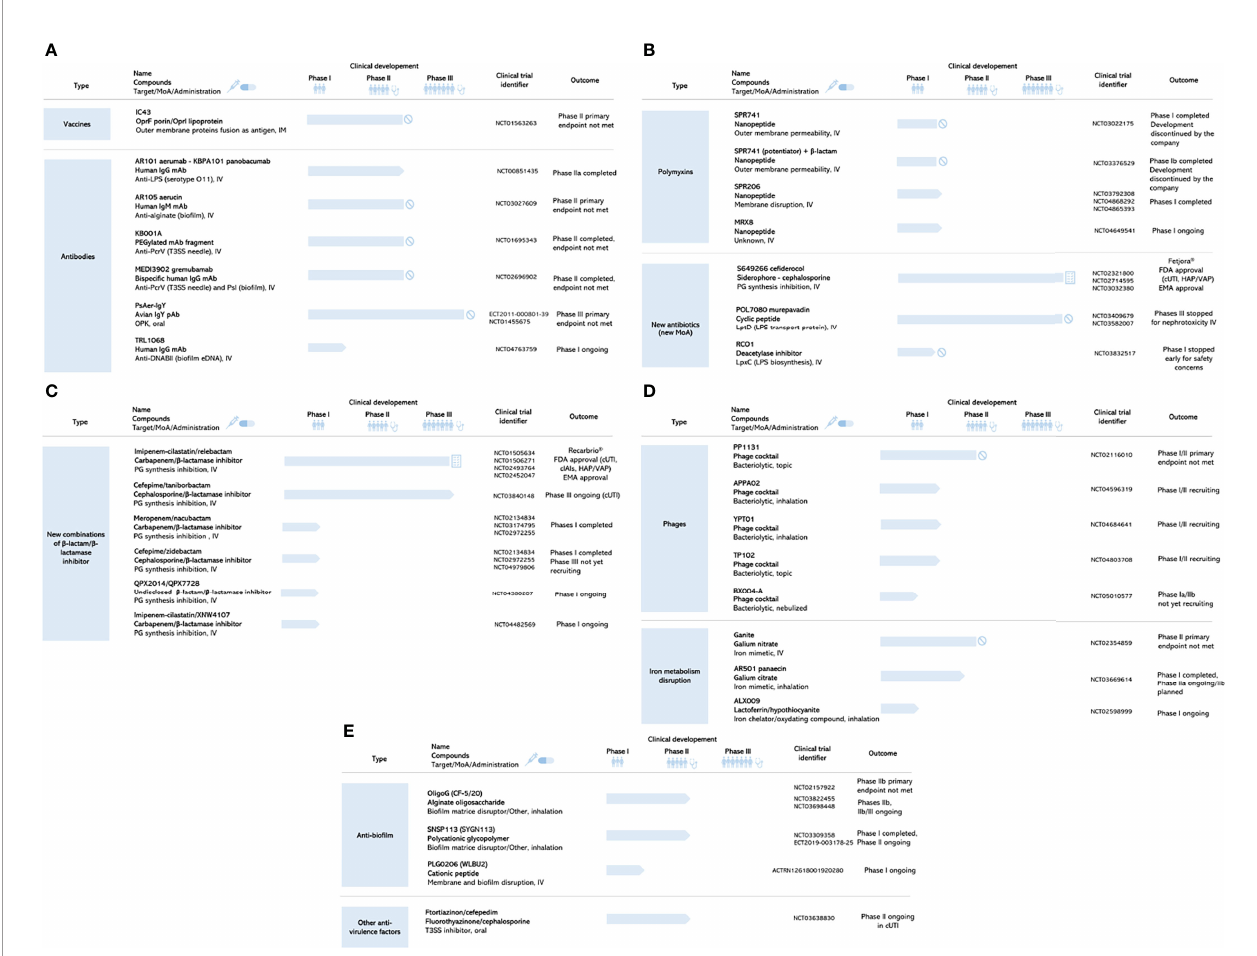
FIGURE 4 | Search results: anti-Pseudomonas aeruginosa clinical development pipeline in December 2021. (A) Vaccines and antibodies. MoA, mode of action; IM, intramuscular; IV, intravenous; Ig; immunoglobulin; mAb, monoclonal antibody; pAb, polyclonal antibody; eDNA, extracellular desoxyribonucleic acid. (B) Polymixins and new antibiotics (new MoA). MoA, mode of action; IV, intravenous; PG, peptidoglycan; LPS, lipopolysaccharide. (C) New combinations of b -lactam/ b -lactamase inhibitor. MoA, mode of action; IV, intravenous; PG, peptidoglycan. (D) Phages and Iron metabolism disruption. MoA, mode of action; IV, intravenous. (E) Anti-bio fi lm and other anti-virulence factors. MoA, mode of action; IV, intravenous; T3SS, type 3 secretion